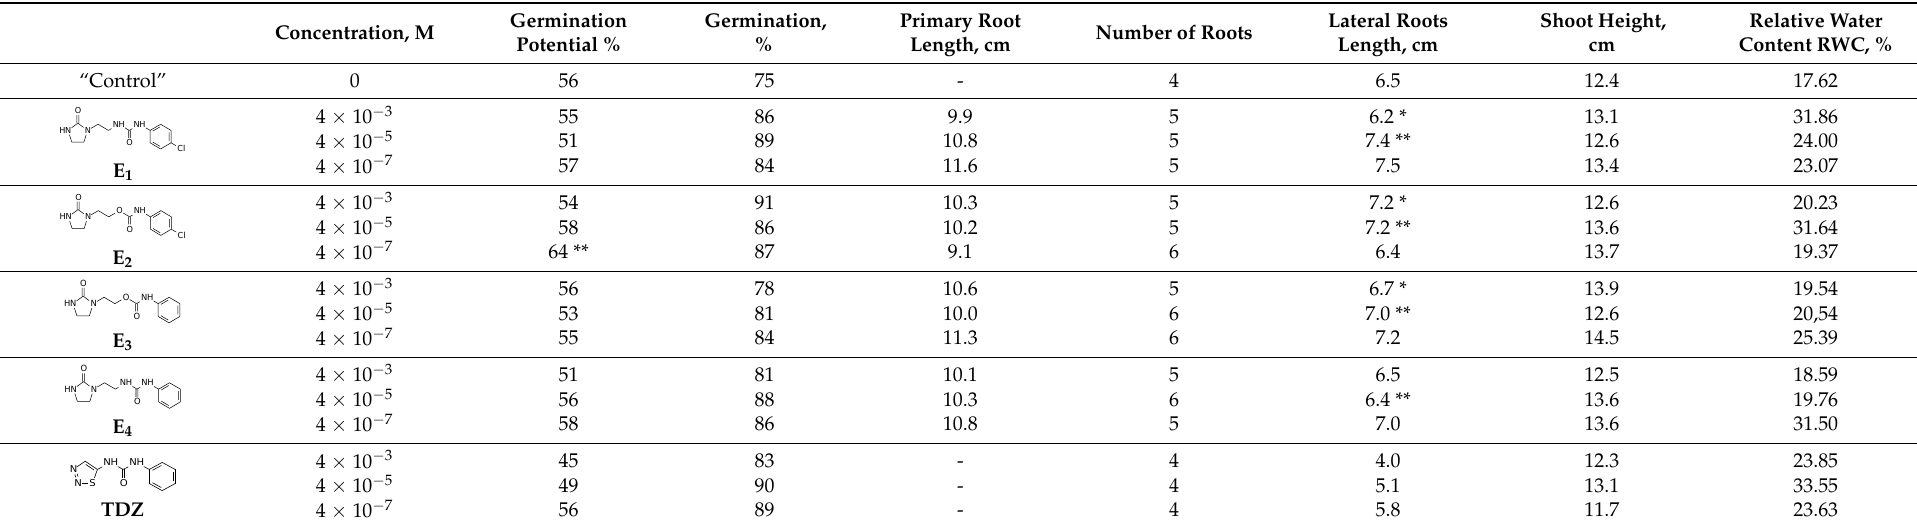
Table 1. The results of laboratory test of compounds E1–E4 and TDZ.